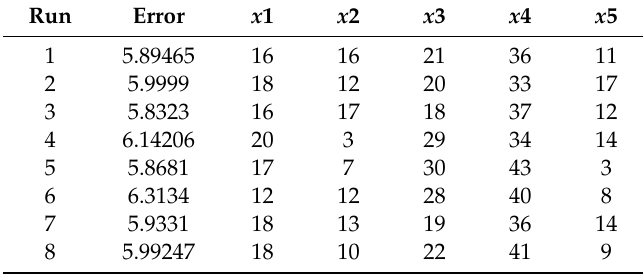
Figure A1. Calculation of weights for the weighted averaging of generated Mean Squared Error. Table A1. Results of the eight executions of the Genetic Algorithm. The optimum solution was generated in Run 3.